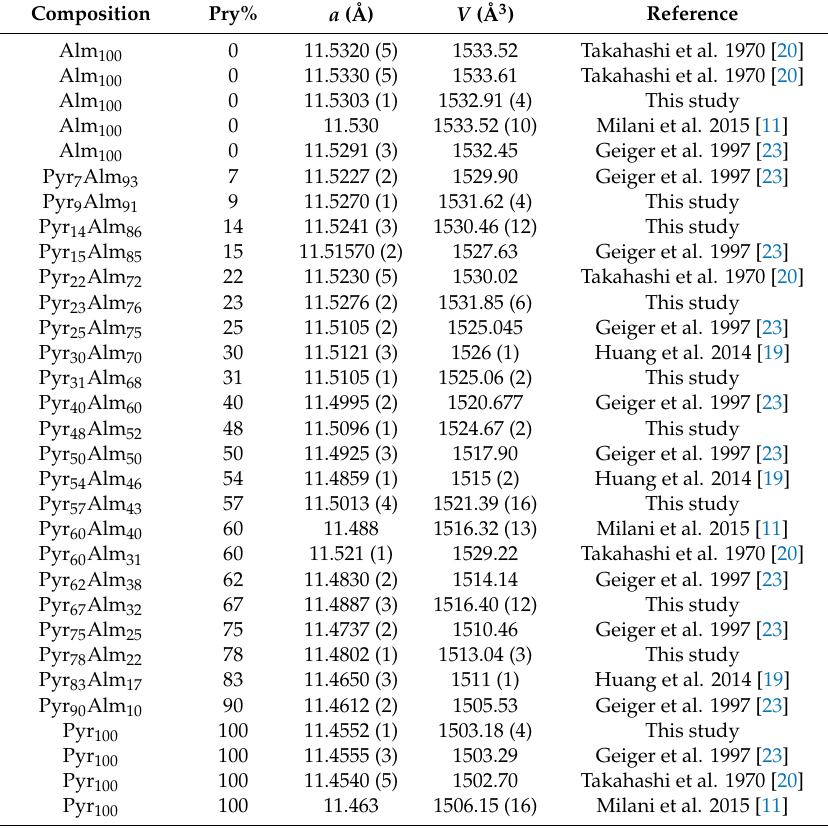
Figure 4. Unit cell constants versus the pyrope mol.% in Alm-Pyr crystals; The data of the previous studies are from the references of Takahashi et al. (1970) [20], Huang et al. (2014) [19], Milani et al. (2015) [11] and Geiger et al. (1997) [23]. Table 2. Unit-cell parameters and unit-volumes for almandine-pyrope crystals in this and previous studies a .